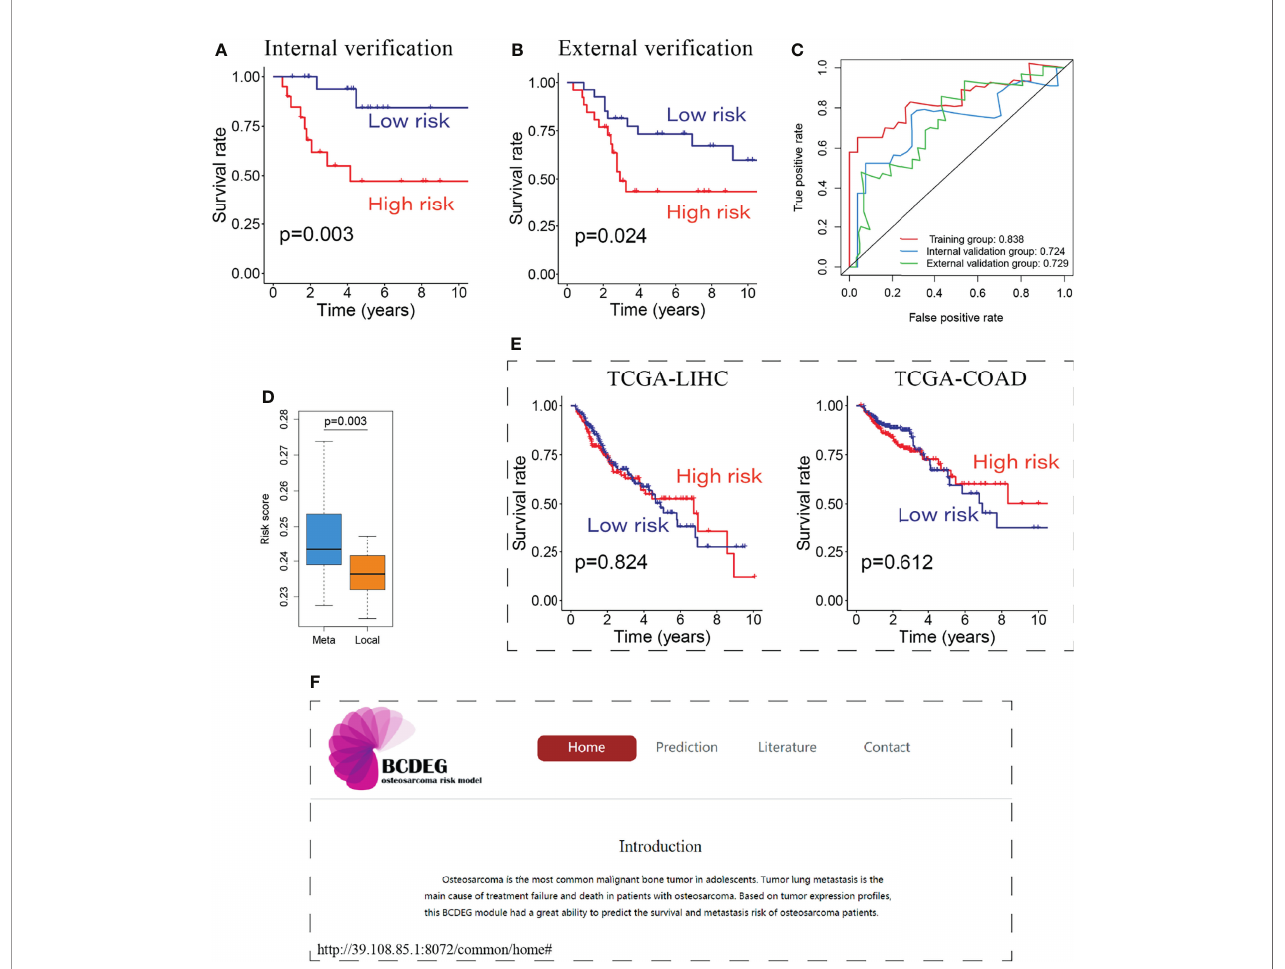
FIGURE 5 | Evaluation of the BCDEG model. (A) Survival curve for the internal veri fi cation group. (B) Survival curve for the external veri fi cation group. (C) Time- dependent ROC curves for three groups. The AUCs of the 3 groups were all greater than 0.7. (D) Box plot showing the difference in risk score between metastatic and localized OS patients. (E) Survival curve for the BCDEG model to predict the prognosis of liver hepatocellular carcinoma and colon adenocarcinoma patients. (F) Snapshots of the BCDEG web